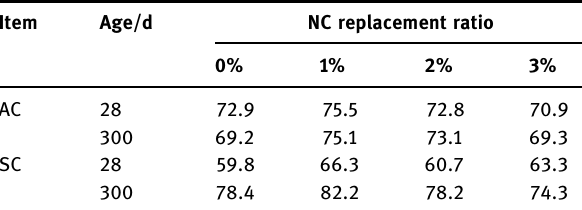
Table 2: Compressive strength of concrete with di ff erent NC replacement ratios ( MPa )